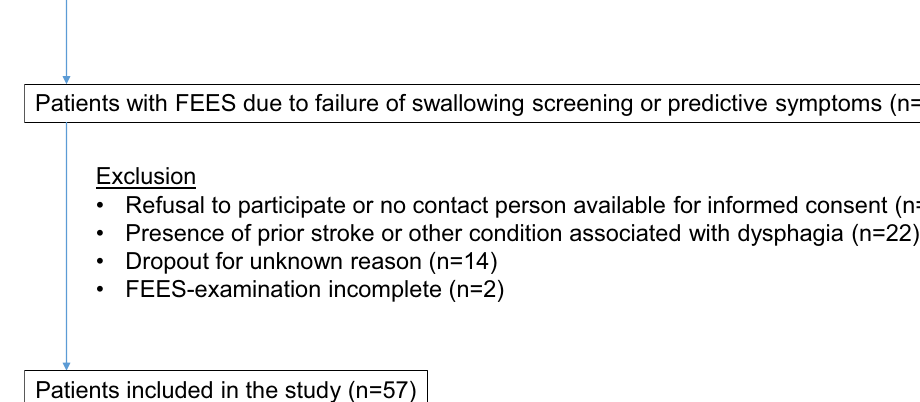
Fig. 1 Flow‑diagram for the exclision of